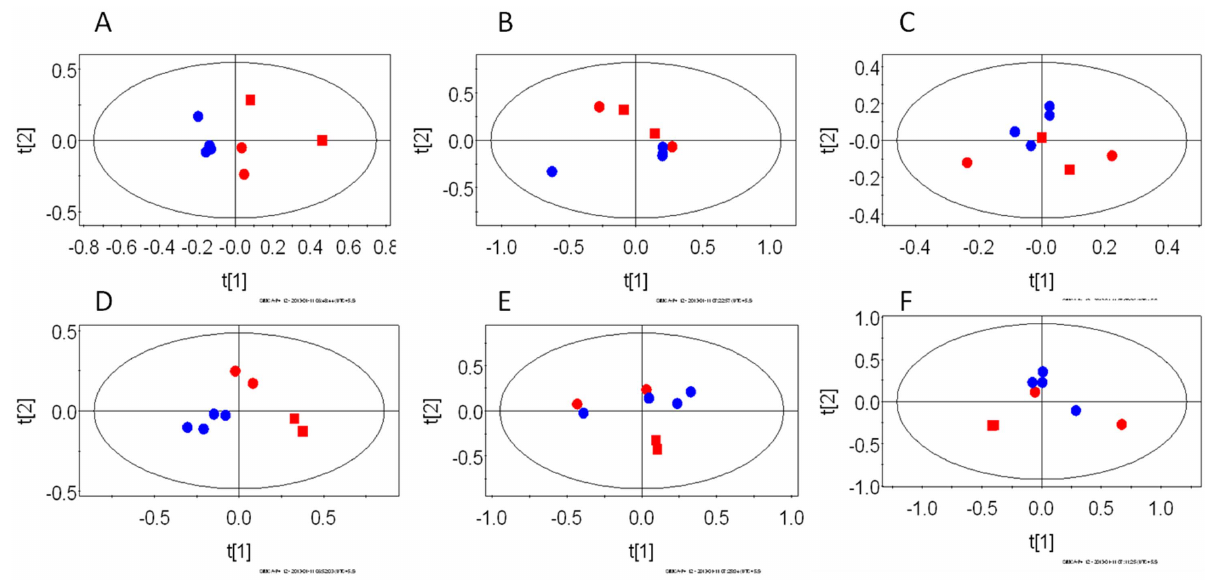
Figure 4. The PCA scores plots of 1 H NMR spectra of Balb/C mice infected with P.chabaudi showing the segregation of uninfected control from infected mice three weeks post-parasite clearance. The recovered time point was taken as the three week post parasite clearance. The plots represent pair-wise models of different biological compartments. A–C represent females and D–F males. A and D- liver, B and E – serum, C and F –brain. In each plot, the red dots are uninfected control and the blue dots represent the animals at three weeks post-parasite clearance. Among the red symbols, the squares represent the control mice sacrificed along with the peak infection animals and the circles represent the animals sacrificed with the three weeks post-parasite clearance animals. square window function was used in both the dimensions with line broadening of 1 and 0.3 Hz along the direct and indirect dimensions, respectively and a Gaussian multiplication of 0.1 Hz along the indirect dimension. These spectra were phase corrected manually and automatically baseline corrected using Topspin 2.1